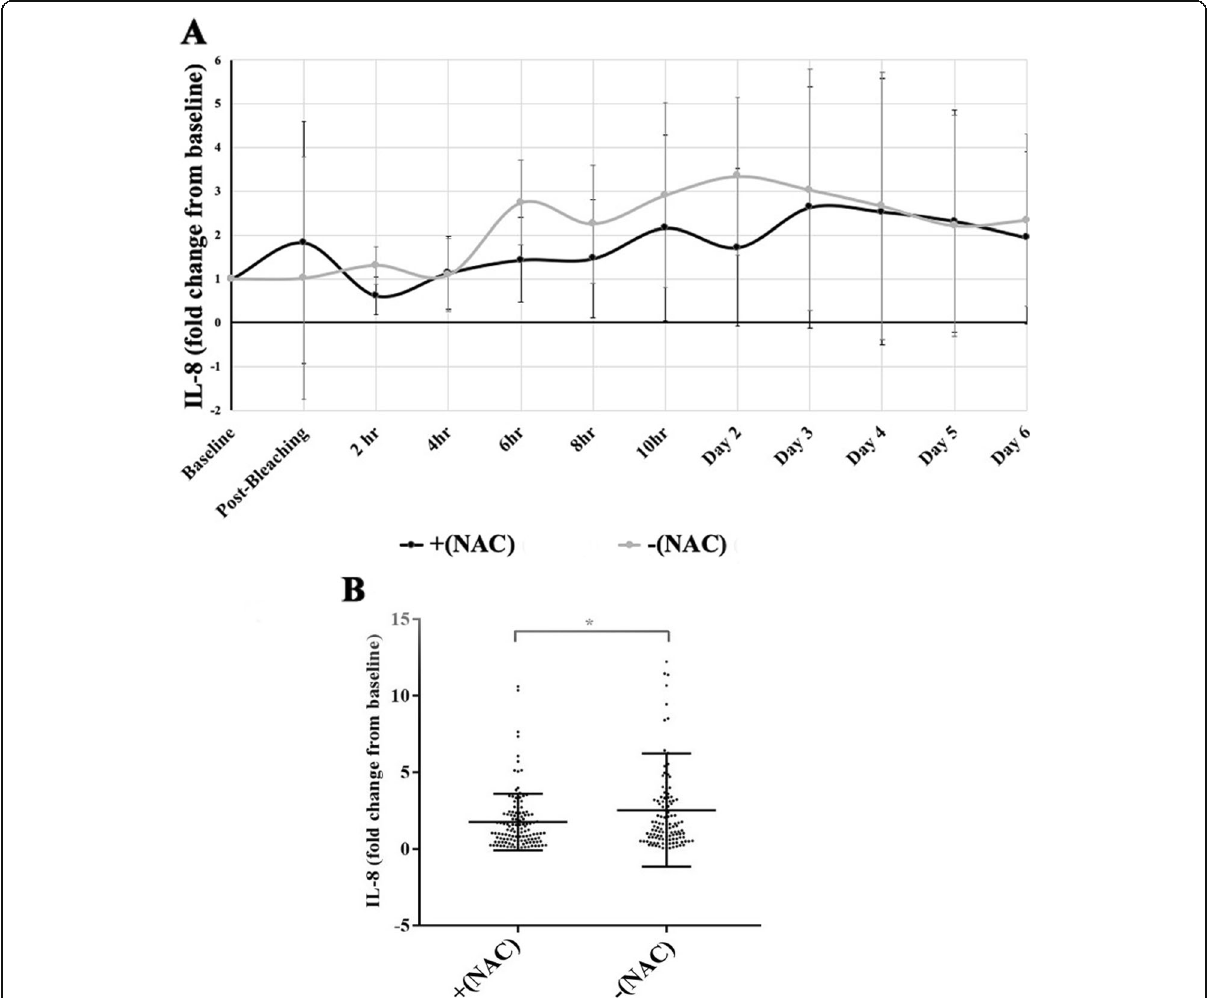
Fig. 6 NAC resulted in decreased levels of IL-8 secretion in saliva after bleaching in patients. Patients ’ saliva samples were collected immediately before and after the bleaching procedures, as well as every two hours post-procedure for the first 10 h, and on daily bases for 5 days. The levels of IL-8 obtained at the pre-bleaching saliva samples were used as the baseline to calculate the fold-change of IL-8 secretion in subsequent time points. The mean fold-change values were plotted for both H2O and NAC-treated patients across all time points ( a ). A combined scatter plot, along with mean and standard deviation, from the 4-h post bleaching to day 3 post-bleaching was generated to examine the distribution of IL-8 changes. Control patients ( n = 20) demonstrated higher IL-8 fold change values compared to NAC patients ( n = 20), with a P -value of 0.038 ( b